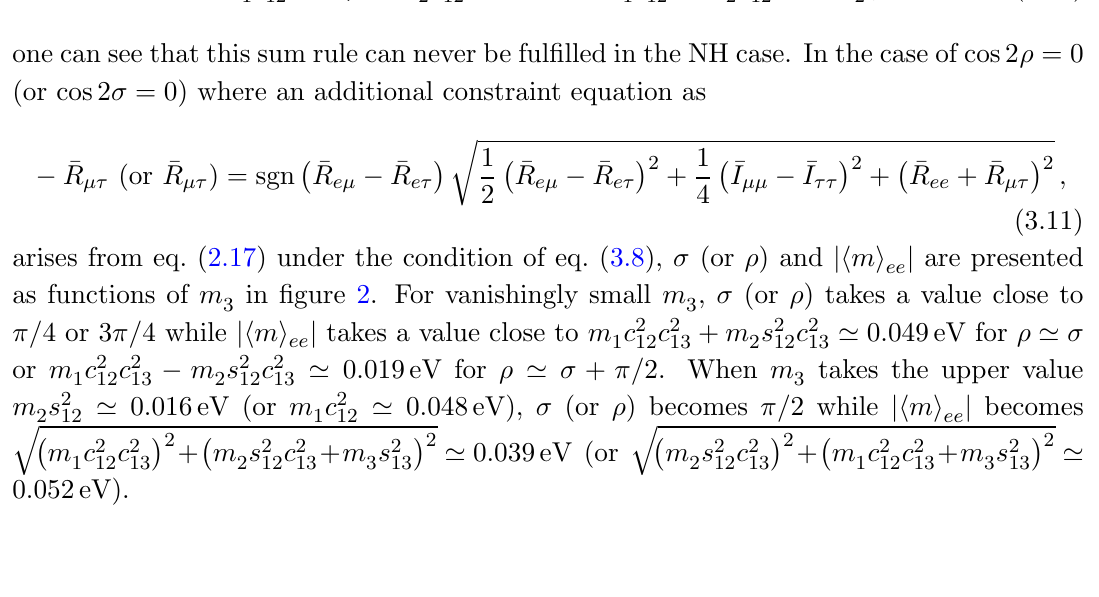
Figure 2 . Left: (cid:26) (or (cid:27) ) as a function of m of equation B being vanishing. Right: jh m i the case of two sides of equation B being